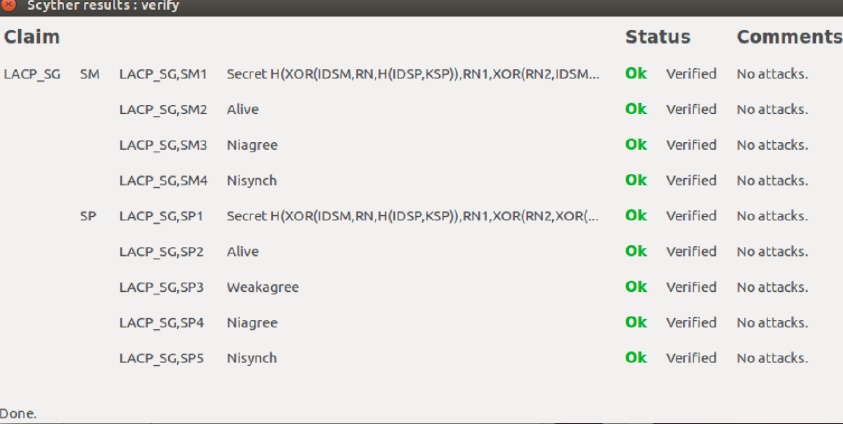
Figure 4. Security analysis of LACP-SG using